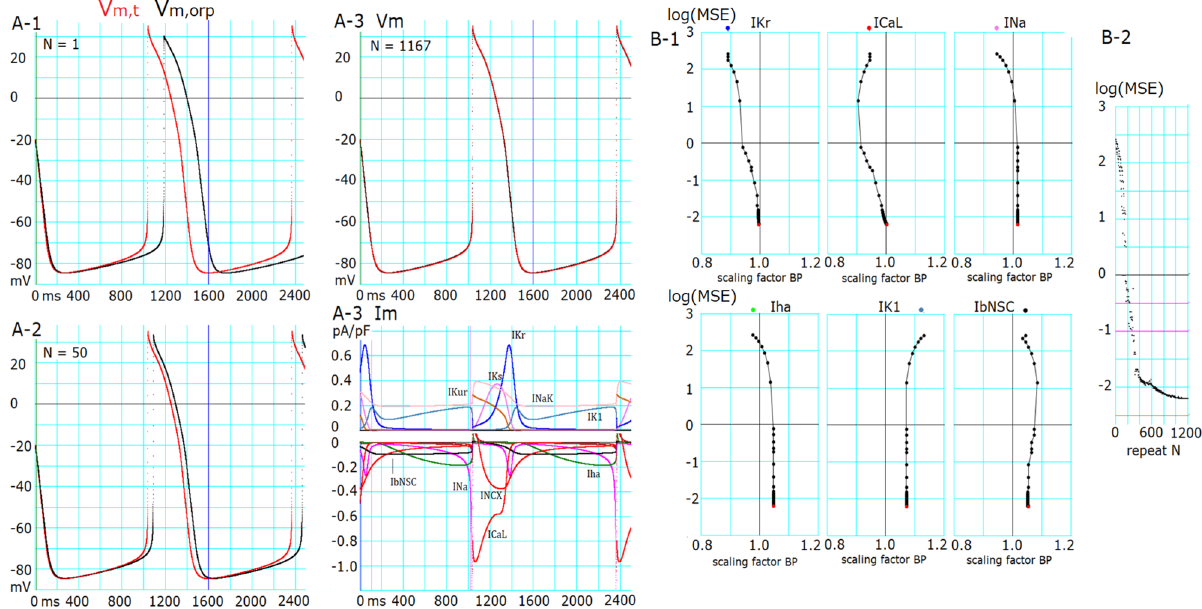
Figure 3. Successful optimization in Cell 86. ( A-1 ) Target AP ( V m,t , red) and AP generated by randomized initial sf x s ( V m,orp , black). ( A-2 ) V m,t (red) and V m,orp (black) generated after 50 cycles of adjusting BP. ( A-3 ) V m : V m,t (red) and V m,orp (black) generated by the final sf x s. I m : corresponding time courses of each current for the finalized AP shown in ( A-3 ) V m . ( B-1 ) Changes in sf x s vs. log(MSE) during a successful optimization process of PS. ( B-2 ) log(MSE) of all BP points during the search process in PS. The initial values of sf x s are plotted by corresponding colors at the top of each sf x -log(MSE) graph.